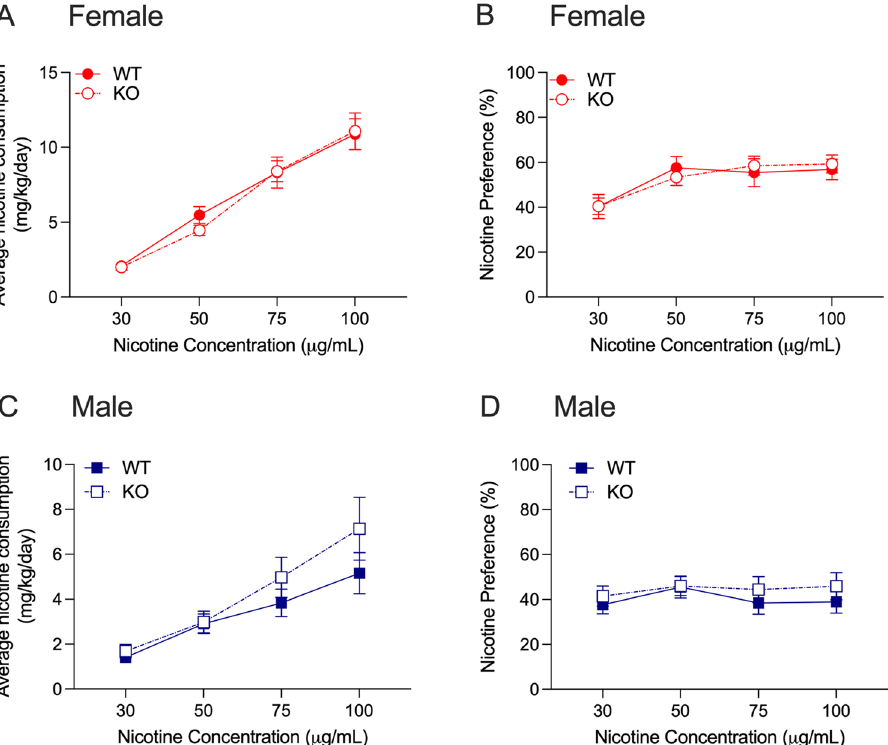
Figure 7. Nicotine consumption and preference in Grk4 WT and KO mice. No differences between female Grk4 WT and KO mice were observed for ( A ) nicotine consumption or ( B ) nicotine preference. No genotype differences were observed in ( C ) nicotine consumption or ( D ) nicotine preference between male Grk4 WT and KO mice. Data are presented as mean ± SEM, n = 16–25 female mice per genotype, n = 16–17 male mice per